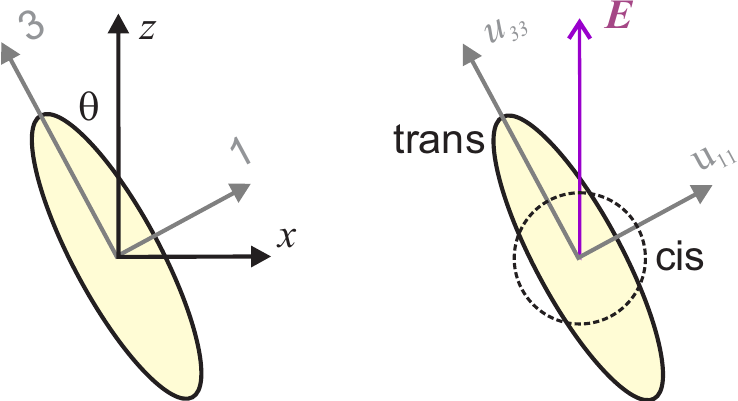
Figure 3. The 123 frame is attached to the molecule with 3 being the uniaxial direction and the lab frame is labelled xyz , where θ is the angle between the z and 3 axes. The trans molecule is approximated as being a uniaxial ellipsoid and the cis isomer as a sphere. u 33 and u 11 are the strains along two of the principle